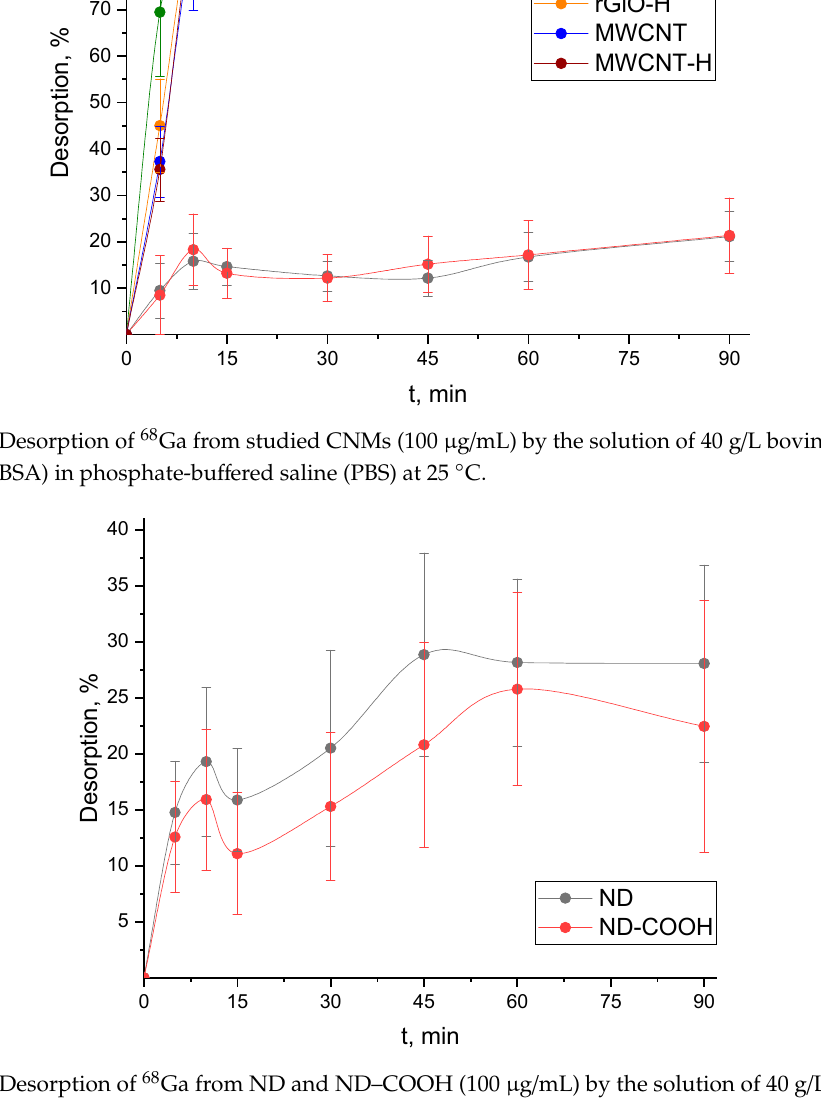
Figure 5. Desorption of 68 Ga from ND and ND–COOH (100 μ g/mL) by the solution of 40 g/L BSA in PBS at 37 °C.